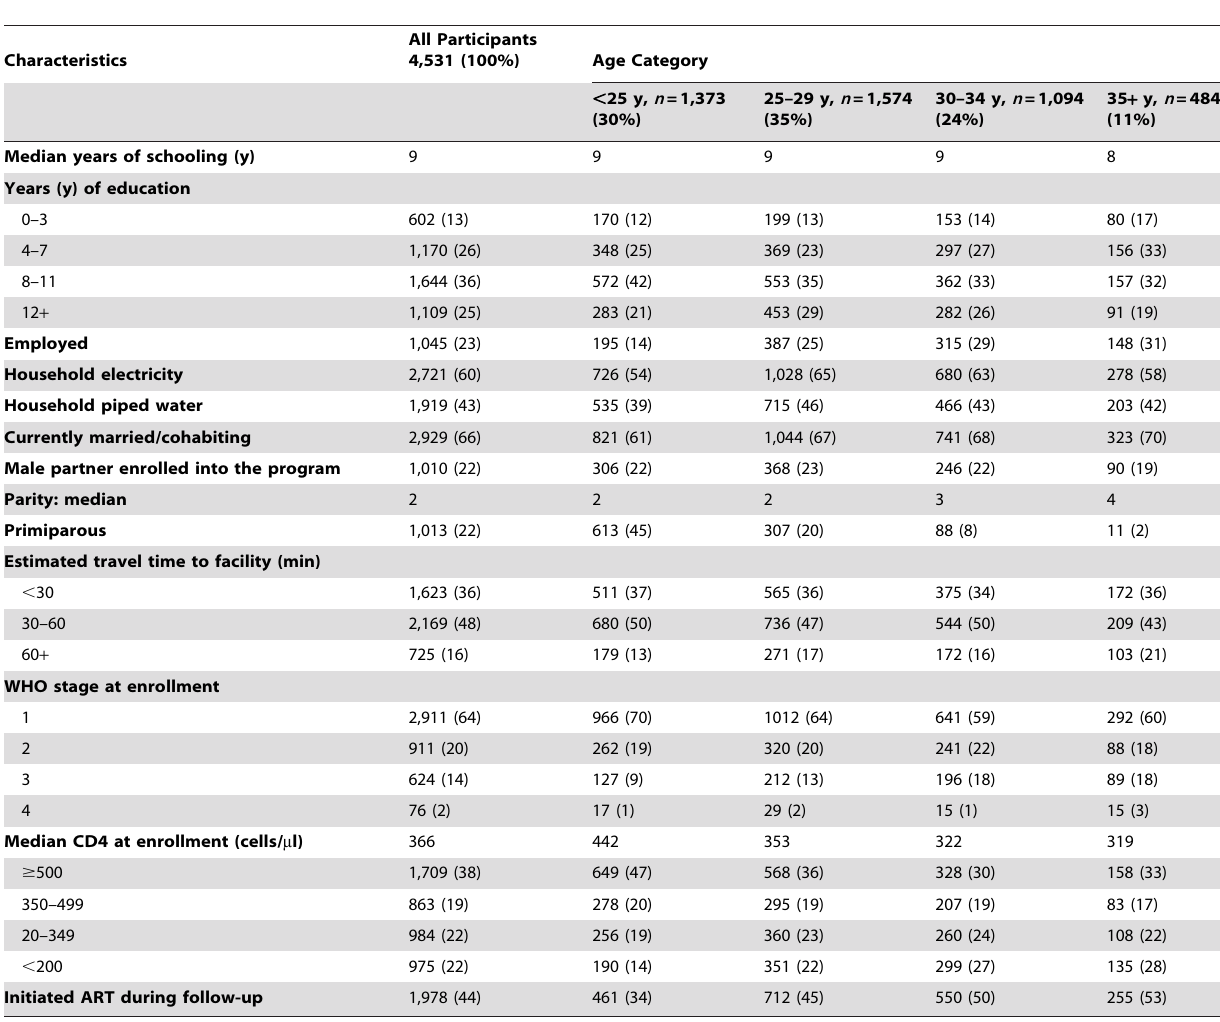
Table 1. Description of sociodemographic and clinical characteristics of the cohort of women enrolled into MTCT-Plus and eligible for incident pregnancy analysis, overall and by age